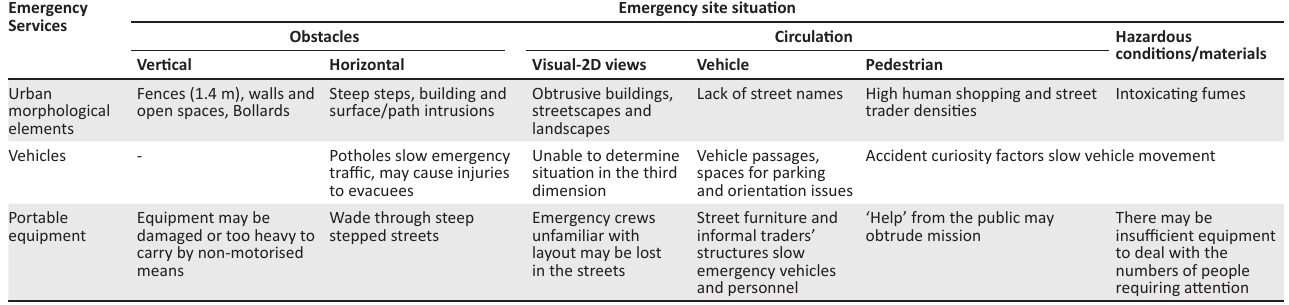
TABLE 3: Hazards generated from ‘worst case scenarios’ for